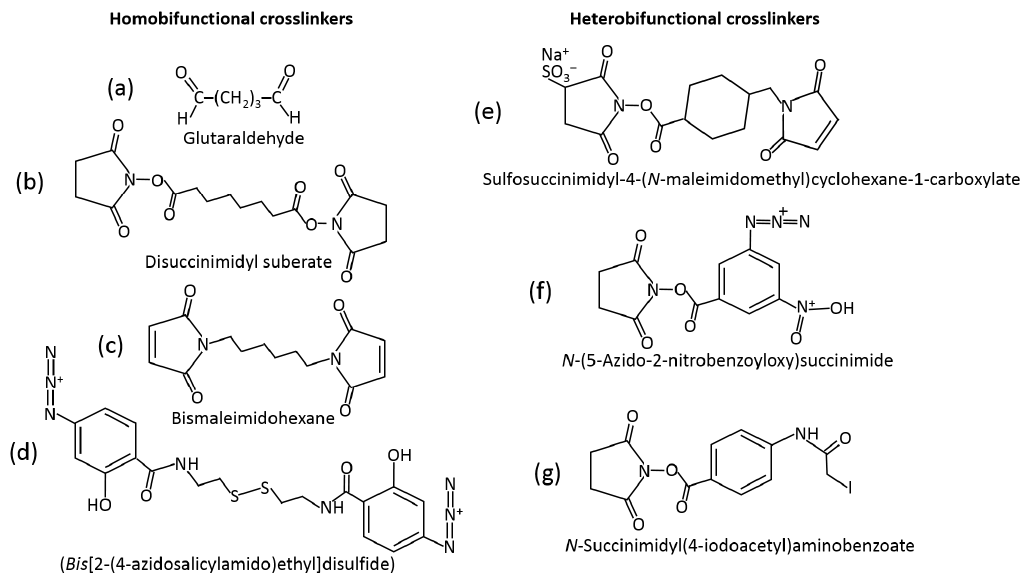
Figure 9. Bifunctional reagents: ( a – d ) homobifunctional—containing two identical reacting groups for binding to the same functional groups of biomolecules; ( e – g ) heterobifunctional—containing two different reacting groups for binding to different functional groups of biomolecules. The fol ‐ lowing reacting groups are shown in the examples given: ( a ) aldehyde groups reacting with amino groups, ( b , e , f , g ) active ester groups reacting with amino or hydroxyl groups, ( c , e ) maleimide and ( g ) iodoacetyl groups reacting with thiol groups, and ( d , f ) azido groups used for click ‐ chemistry reactions. The spacers separating the reacting groups can be flexible ( a – d ) or rigid ( e – g ), thus result ‐ ing in different attachment modes of biomolecules. The spacer length can be different, short or long, and some spacers can be cleavable due to S–S bonds ( d ) or other chemically or photochemically cleavable units. Example reactions for biomolecule binding using homobifunctional and heterobi ‐ functional cross ‐ linkers are shown in Figures 10 and 11, respectively. Note that homo ‐ bifunctional reagents have the same functional groups at both sides of the spacer, while heterobifunctional cross ‐ linkers possess different functional groups at both sides. Figure 10. A homobifunctional cross ‐ linker containing two active ester functions used to bind bio ‐ molecules by reacting with their amino groups and producing amido bonds. Note the long and